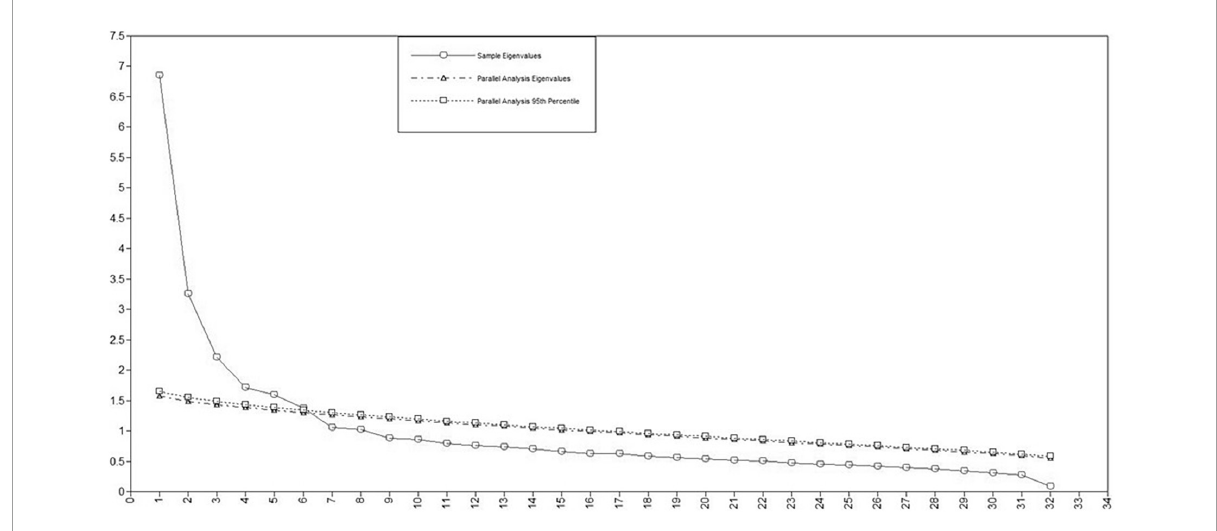
FIGURE1 Parallel analysis results of the home learning environment questionnaire (HLEQ).